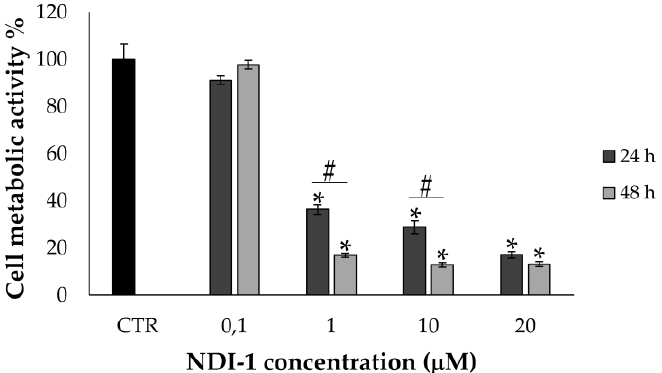
Figure 4. Cell metabolic activity % of U373 cells treated with increasing doses of NDI-1 for 24 and 48 h. Untreated cells at 24 h were considered CTR (100% of metabolic activity). Multifactor ANOVA, mean values ± least significant difference (LSD), n = 4. * p < 0.01 with respect to CTR-; # p < 0.05.